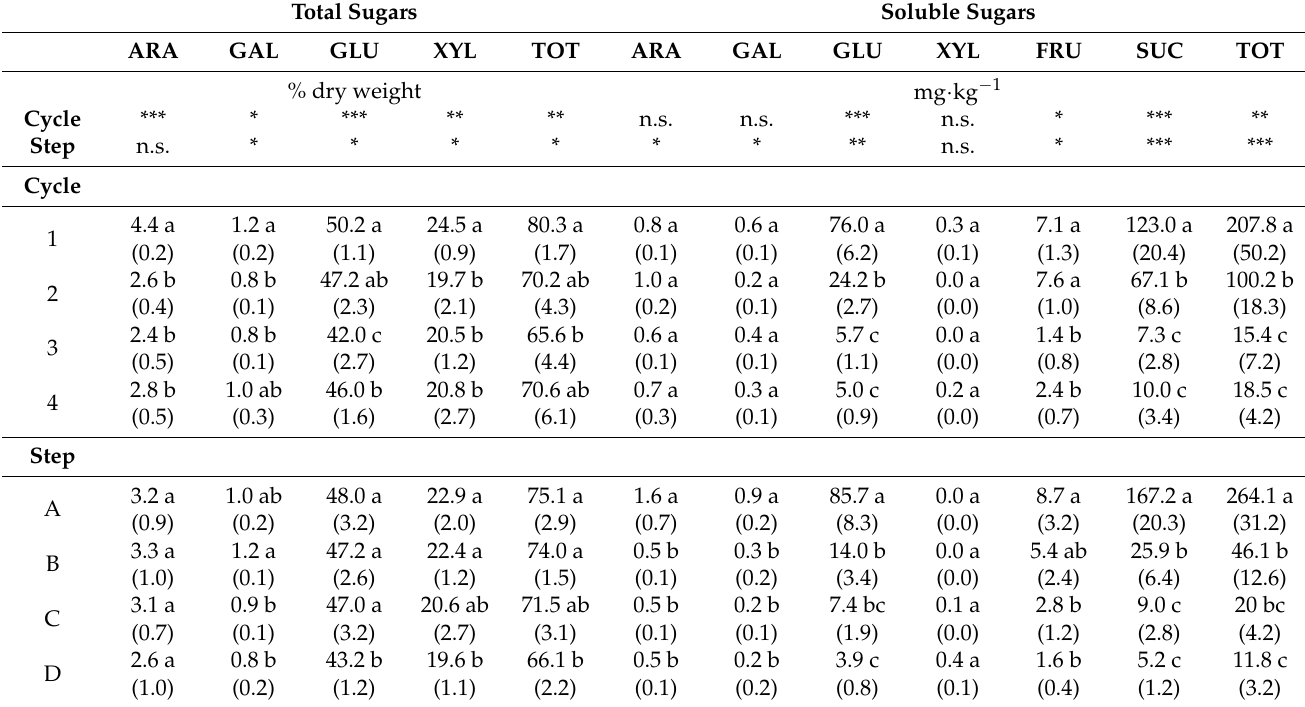
Table 4. Total and soluble sugars at the end of different cycles of production and after different steps of preparation. ARA: Arabinose, GAL: Galactose, GLU: Glucose, XYL: Xylose, FRU: